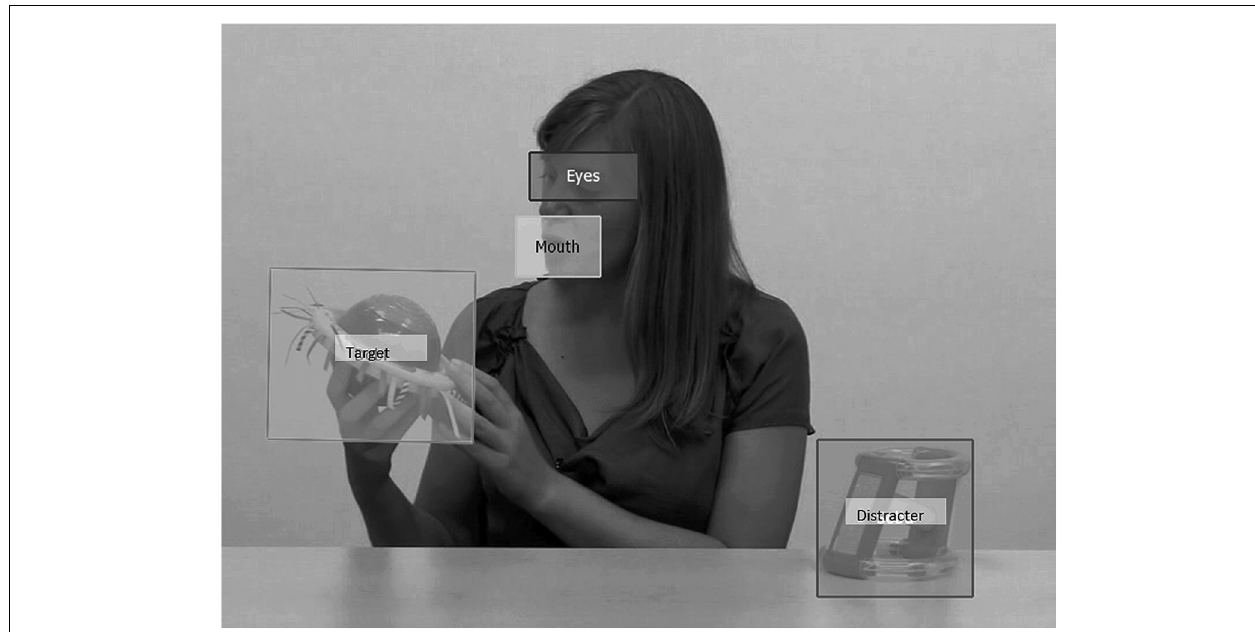
FIGURE 2 | Screen capture from familiarization trial with regions of interest (eyes, mouth, target,